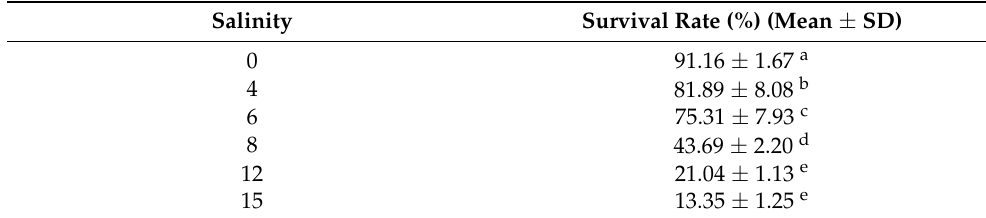
Table 2. The survival rate of M. macrocopa on different ranges of salinity. All values are mean ± stan- dard deviation ( n = 3). The different small letters indicate significant differences between different salinity ( p < 0.05).